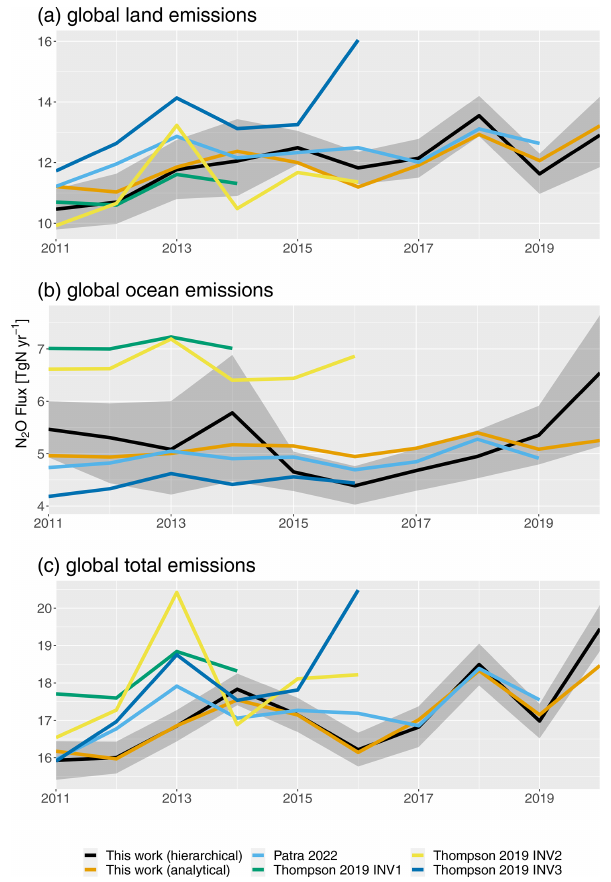
Figure 5. Variation in global annual nitrous oxide emissions over 2011–2020 inferred here and in recent atmospheric inversions (Thompson et al., 2019; Patra et al., 2022), for (a) the global land, (b) the global ocean, and (c) the global total emissions. The shading represents the 95% credible interval on the mean estimate in this work.